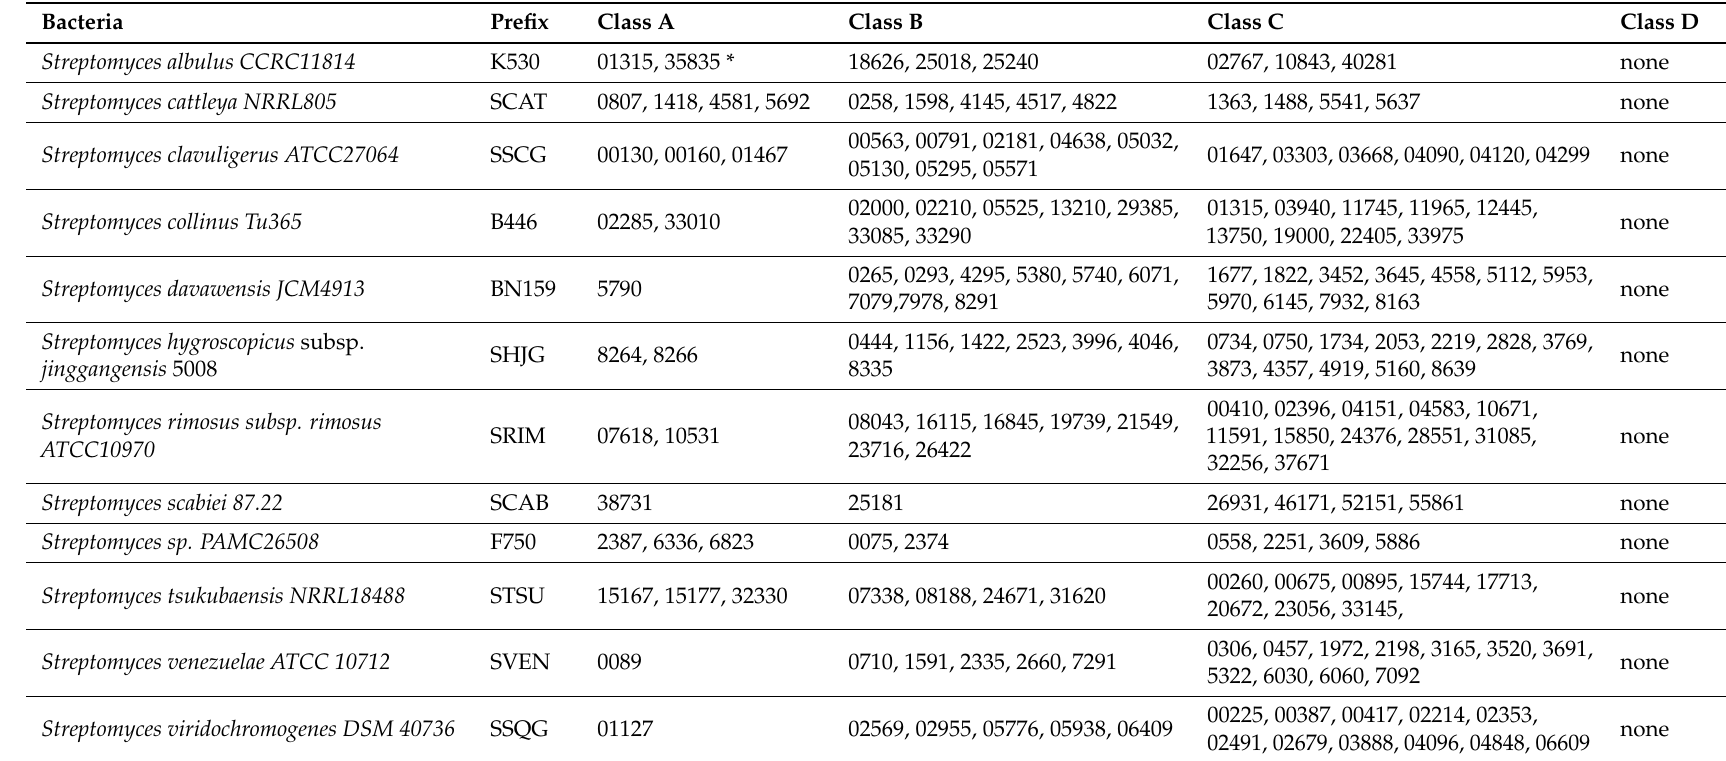
Table 1. Classification of β -lactamases in 12 Streptomyces